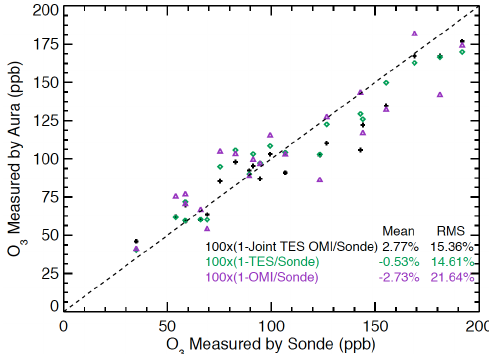
Figure 9 . Correlations of Aura measured and ozonesonde measured ozone concentration in parts-per-billion (ppb) in the region from 700hPa to 100hPa: Joint OMI and TES (black pluses); TES (green diamonds); OMI (purple triangles). For joint TES/OMI measure- ments the mean differences of 2.8% and 1 σ standard deviation to mean differences of 15.4%; for TES measurements alone, − 0.5% and 14.6%; for OMI measurements alone, − 2.7% and 21.6%. The discrepancy between joint observations and sonde measurements is larger (mean: 1.24%; RMS: 0.75%) than that between TES only measurements and sonde measurements. Both joint observations and TES only measurements show better agreement to sonde mea- surements than OMI only measurements. A common a priori ozone profile was used in the retrievals for all of the scenes. The averaging kernels of Aura measurements were not applied to the ozonesonde